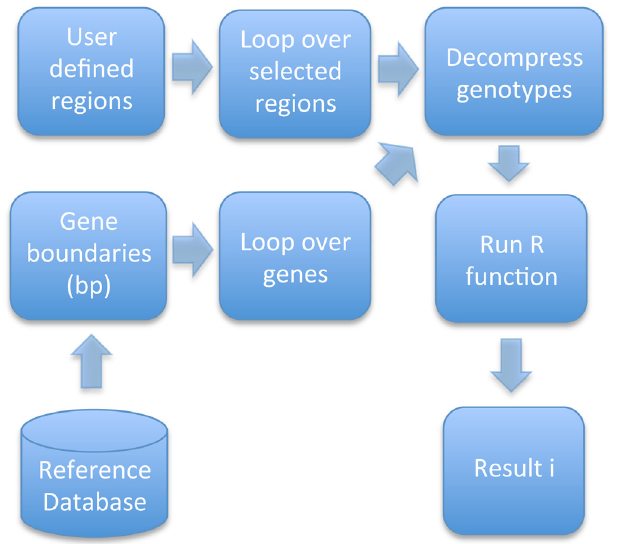
Figure 2. Mega2R provides an efficient and flexible wrapper for iterating through gene regions, running R functions on variants within the desired